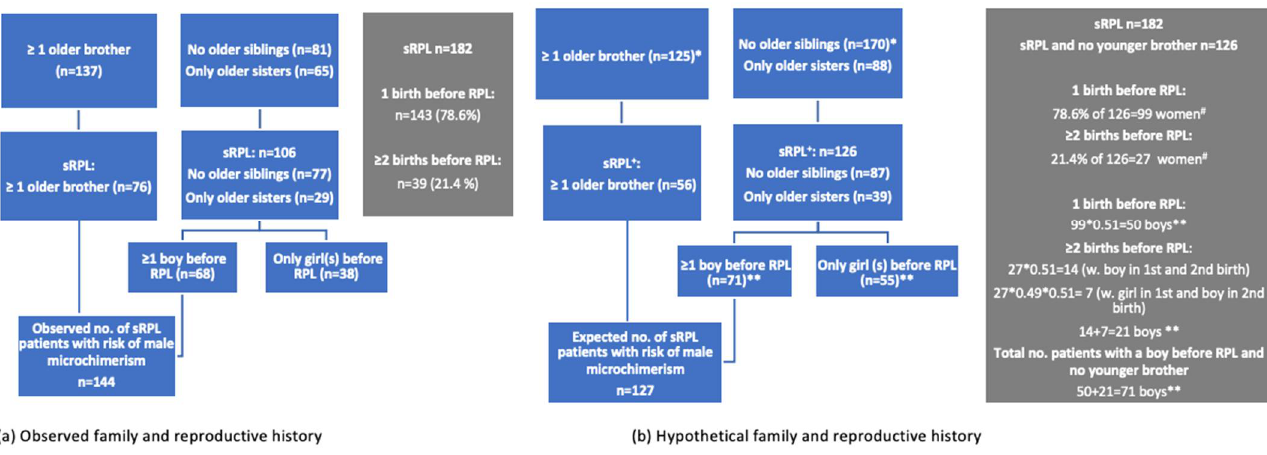
Figure 2. ( a ) The observed distribution of older siblings and children born before RPL according to sex to the left and ( b ) the hypothetical distribution of the same parameters to the right, which was based on distribution of the younger siblings and a 1.04 male:female sex ratio in newborns. The blue boxes illustrate how we calculate the observed and hypothetical number of women with an older brother and/or prior birth of a boy. The grey boxes illustrate ( a ) the observed distribution of 1 and ≥2 children born before RPL and ( b ) the calculation of the hypothetical number of women with birth of ≥1 boy used in the blue boxes, an estimate based on the observed distribution of 1 or ≥2 children. * Calculation based on frequency of having at least one younger brother (left upper box), or only sister(s) and no younger siblings among sRPL patients (right upper box) (see Table 1). + Among the 182 patients, 56 had at least one younger brother, while 126 had only sister(s) or no younger siblings. # Calculation based on the observed distribution of 1 (78.6%) or ≥2 children (21.4%) before RPL. ** Calculation based on the known 1.04 sex ratio of newborn children in the Danish background population.